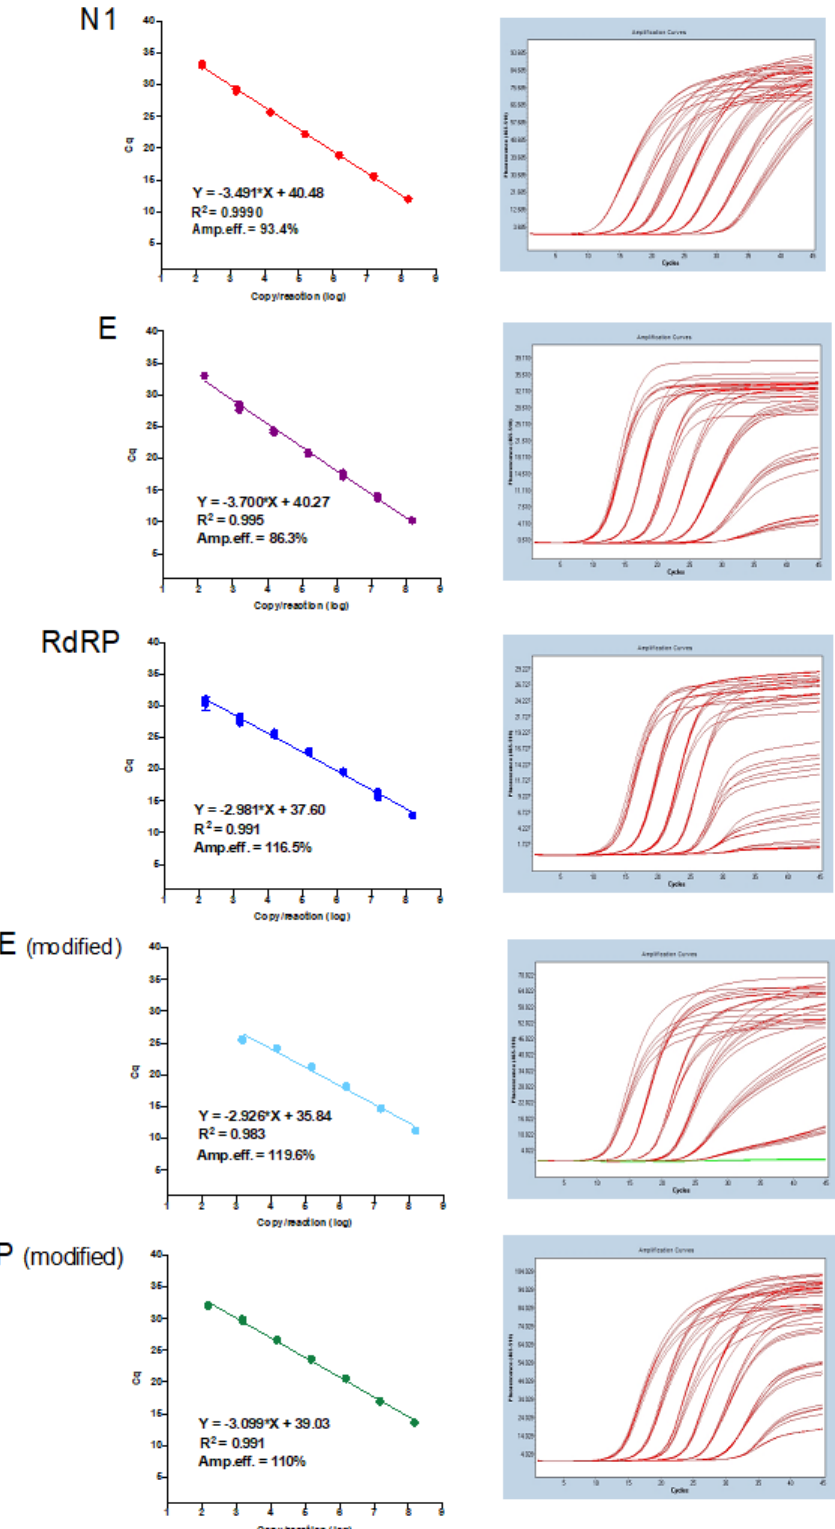
Figure 3. Assays (cid:48) amplification e ffi ciency analysis. Left panel—linear regression analysis; Figure 3. Assays′ amplification efficiency analysis. Left panel—linear regression analysis; right right panel—raw data. The better amplification e ffi ciency was observed for N1 (close to 100%), panel—raw data. The better amplification efficiency was observed for N1 (close to 100%), followed followed by RdRP (modified), E, RdRP, and E by RdRP (modified), E, RdRP, and E (modified).